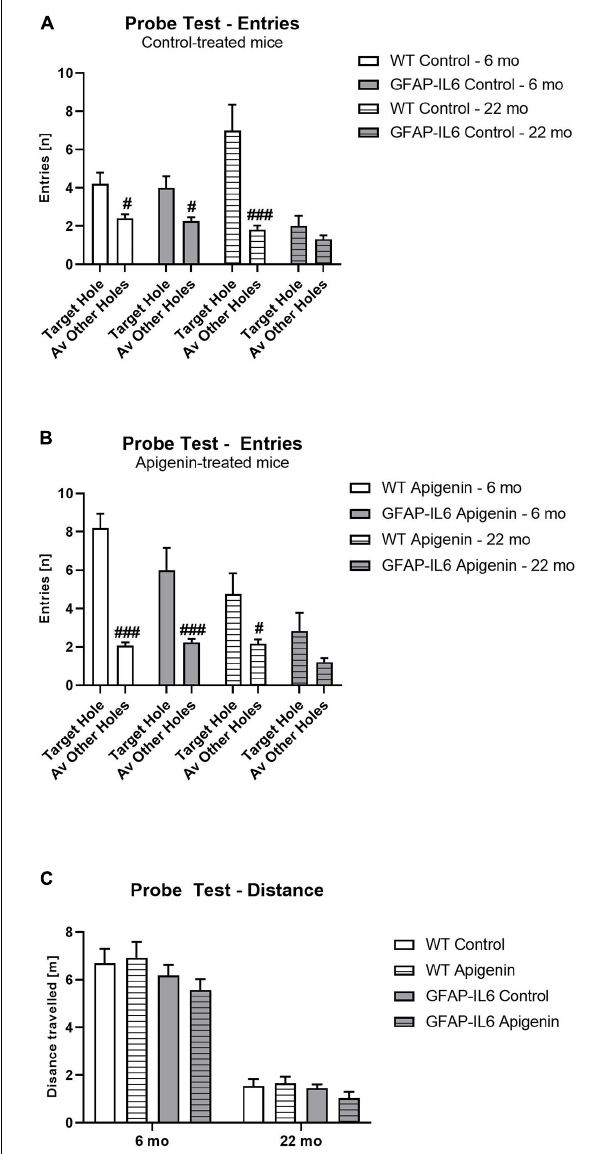
22 months, only WT mice entered the escape hole more than chance [WT standard diet-fed: t (9) = 2.27, p = 0.049; GFAP- IL6 standard diet-fed: t (9) = 1.35, p = 0.2; WT apigenin-fed: t (11) = 2.24, p = 0.047; GFAP-Il6 apigenin-fed: t (9) = 1.85, p =